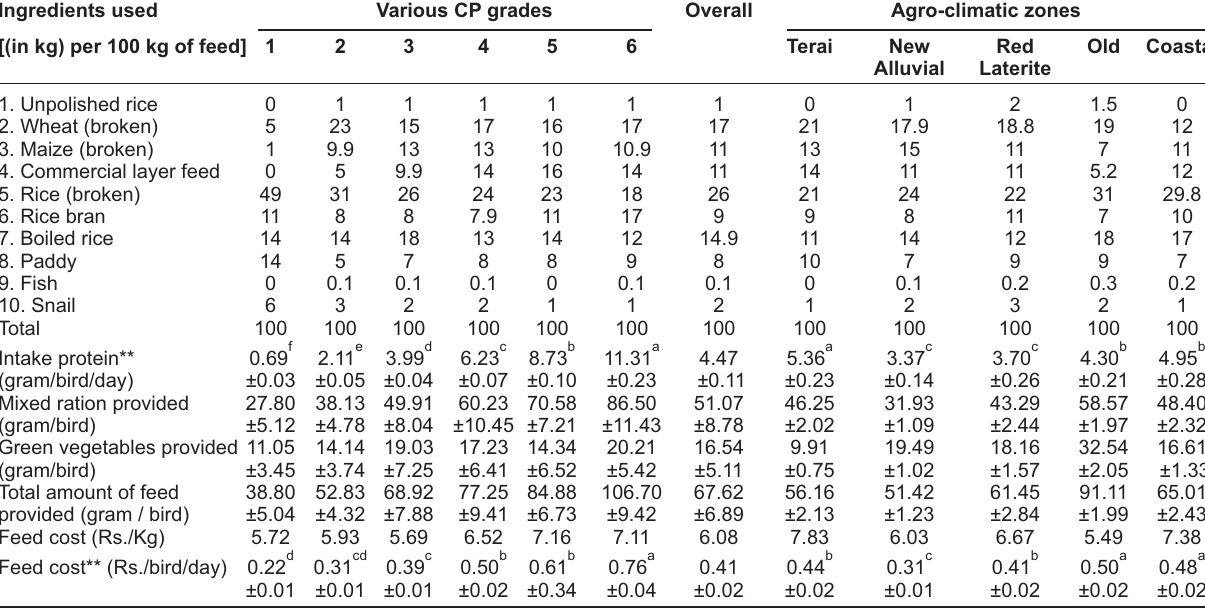
Table-1: Ration formulated by the farmers for backyard rearing RIR chickens in different agro-climatic zones of West Bengal, India using local resources with its cost. Ingredients used Various CP